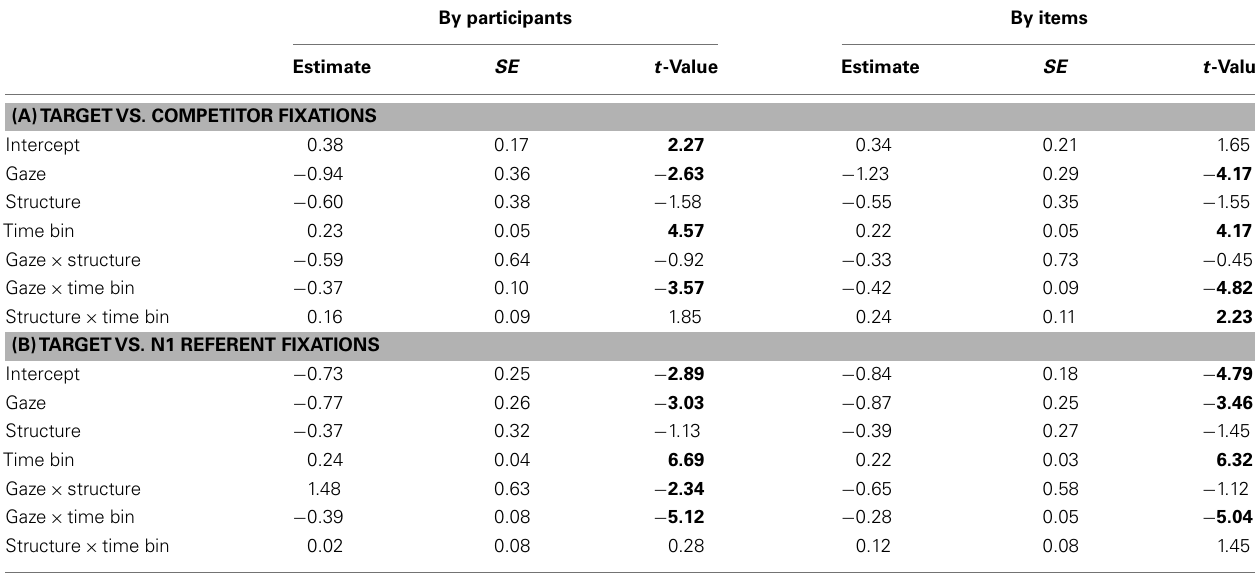
Table 6 | Experiment 2, SHIFT time window: Coefficients, SE and t -values for the final models of log-ratios of target fixations. By participants By items Estimate SE t -Value Estimate SE t -Value